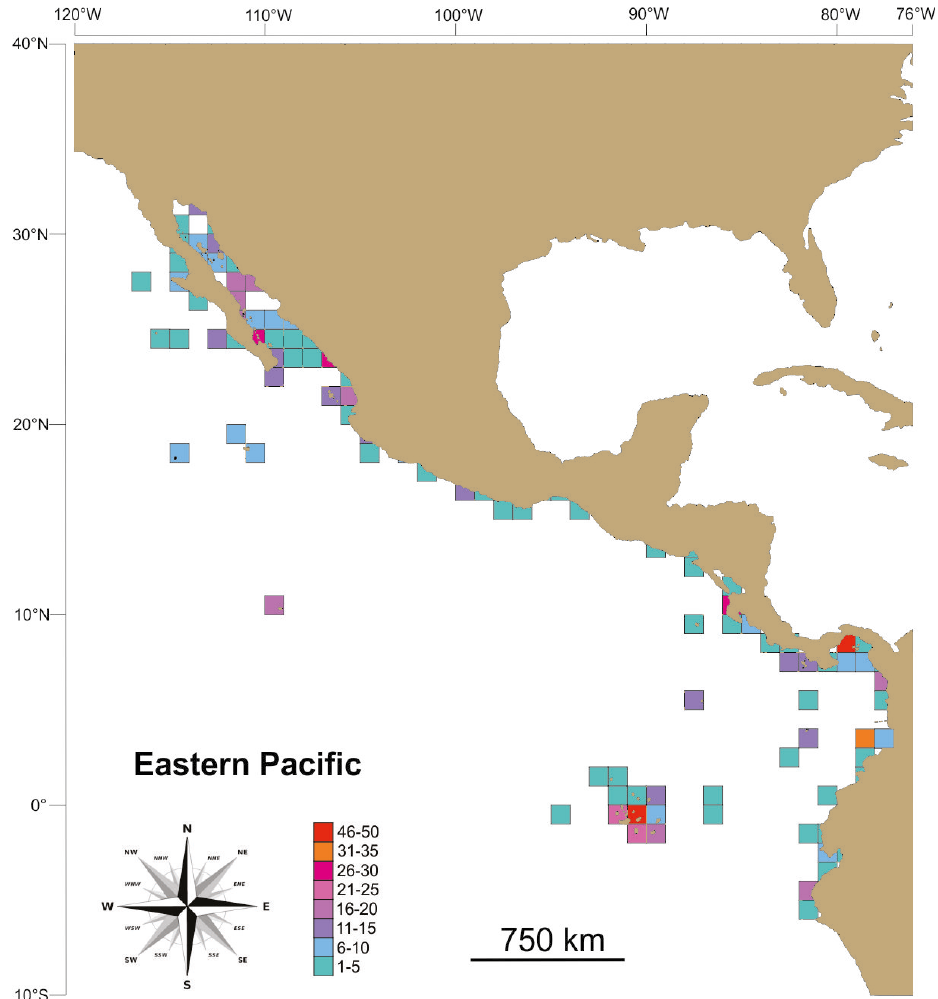
Figure 3. Species richness of marine benthic caridean shrimps per grid (1° latitude by 1° longitude) in the Eastern Tropical Pacific. Notice color